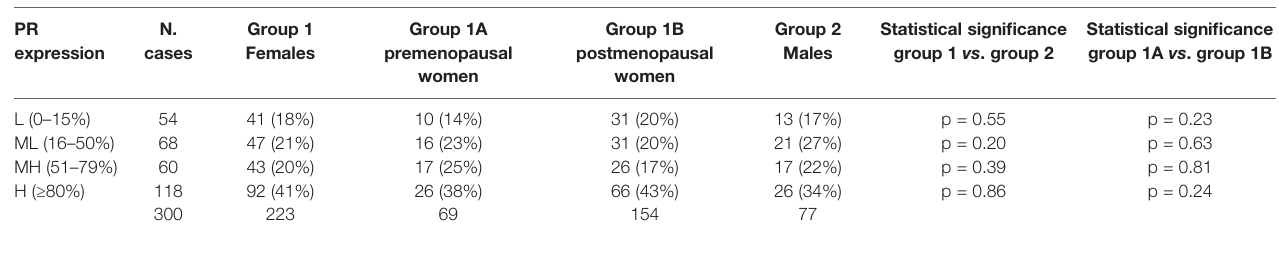
TABLE 2 | PR expression and patient sex.